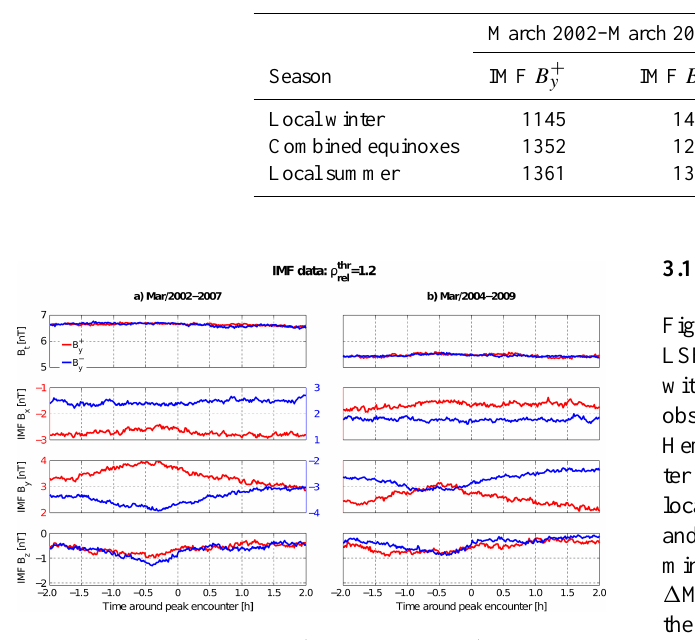
Fig. 2. The averaged profiles of (from top to bottom) the total mag- netic field B t and IMF B x , B y , and B z components for two periods: (a) March 2002–March 2007 and (b) March 2004–March 2009. The results are shown as functions of IMF B + y (red) and B − y (blue) for = 1 . ρ thr rel